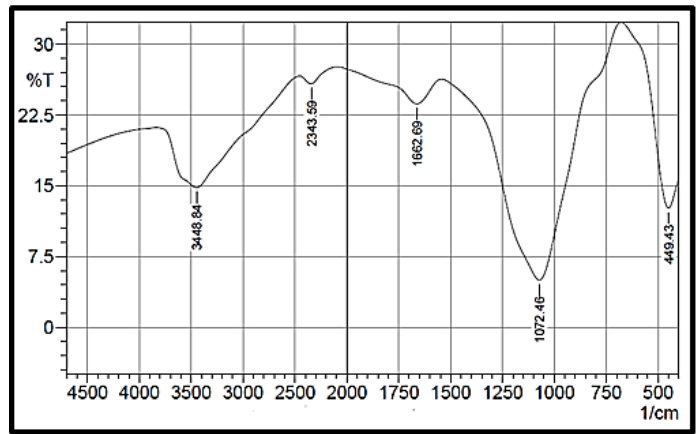
Figure 2. FTIR spectrum of the prepared NPS powder.